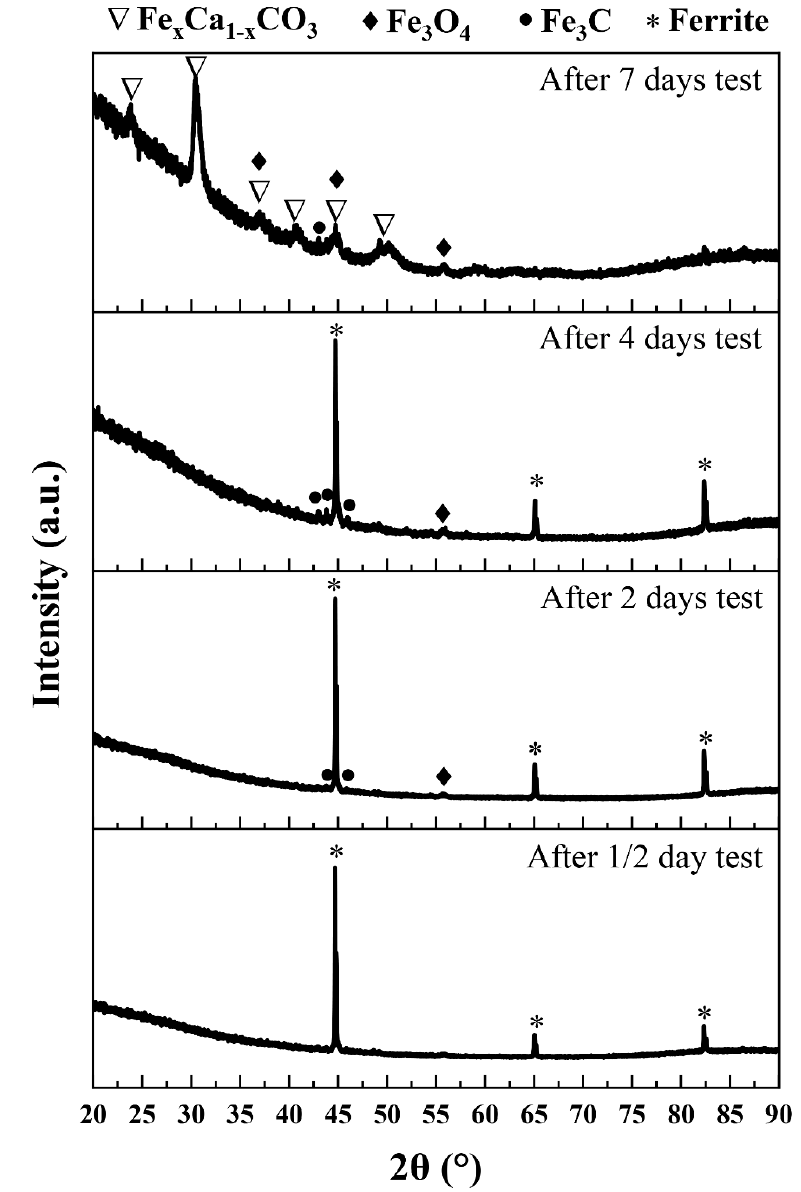
Figure 12. XRD patterns of L245N standard steel after different times.